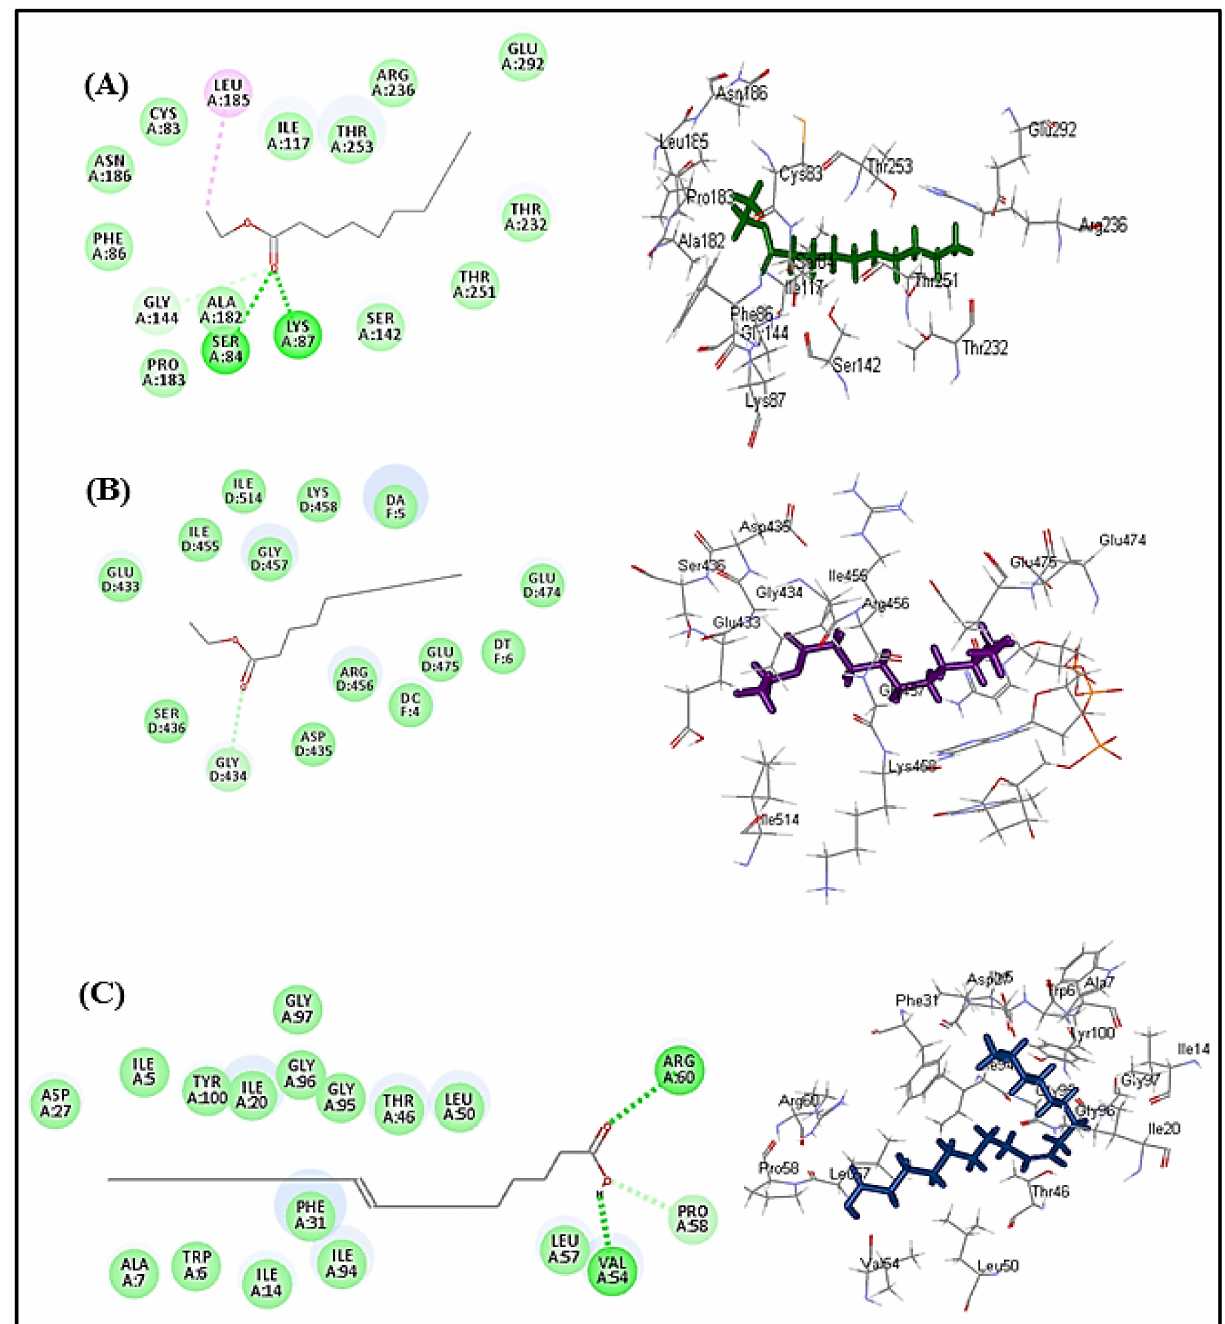
Figure 5. The 2D and 3D binding modes of decanoic acid ethyl ester within the binding sites of ( A ) β -lactamase, ( B ) DNA-gyrase and ( C ) oleic acid within the active sites of dihydrofolate